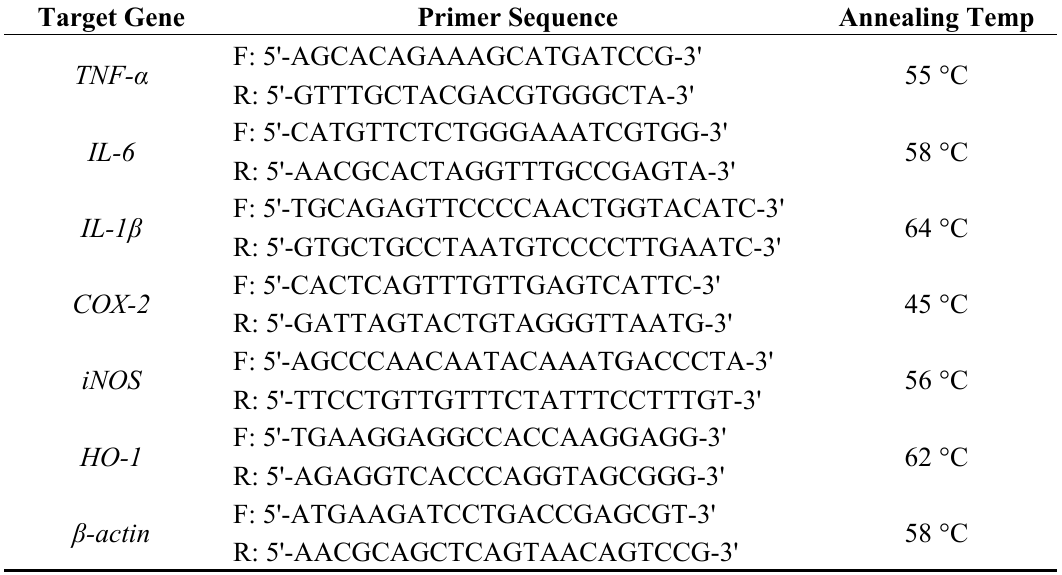
Table 4. Primer sequences and annealing temperatures used for RT-PCR